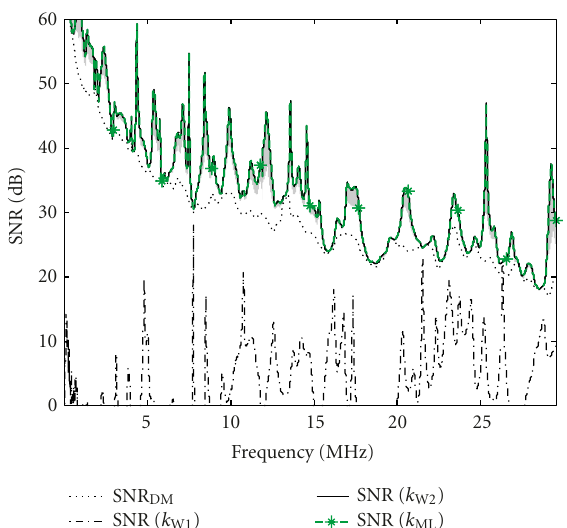
Figure 5: SNRs of adaptive cancellation compared to processing of DM signal only for a transmission over a loop of 300 m length with two FEXT sources ( S = 2) located at the same distance and trans- mitting with the same PSD of − 60 dBm/Hz as the far-end transmit- ter. The background-noise level on both DM port and CM port is − 140 dBm/Hz. The grey-shaded area indicates SNR values for coef- ficient mismatch of up to 50% (SNR( K 0 . 5 )).